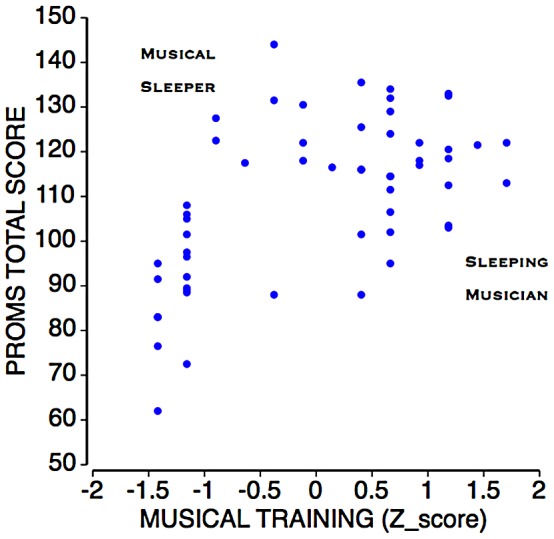
Scattergram plotting PROMS performance against an aggregate index of musical training.Training includes years of musical training, music degrees and qualifications, critical listening activities, and musicianship status (main text). Extent of training predicts PROMS performance substantially but imperfectly (r = .57, p<. 01). Upper left corner: Example of a “musical sleeper” performing well despite minimal musical training. Lower right corner: Example of a “sleeping musician” posting a lesser performance despite extensive musical training.